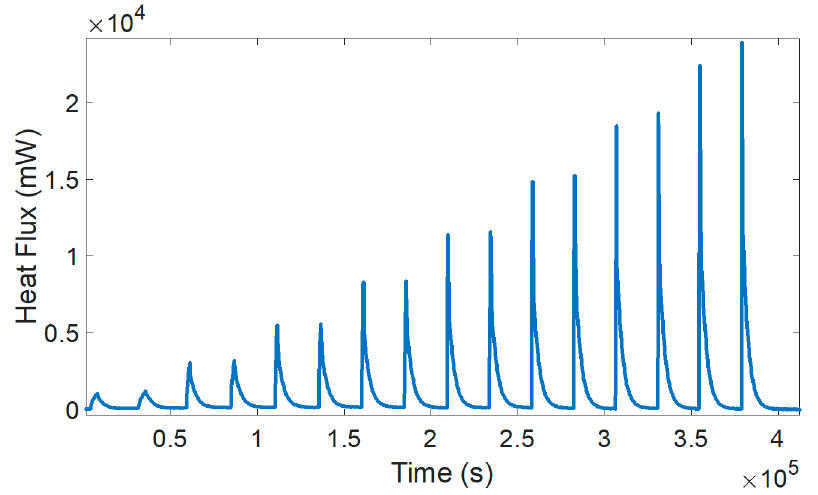
Figure 5. Heat flux of the battery cell during charging and discharging at different current rates.